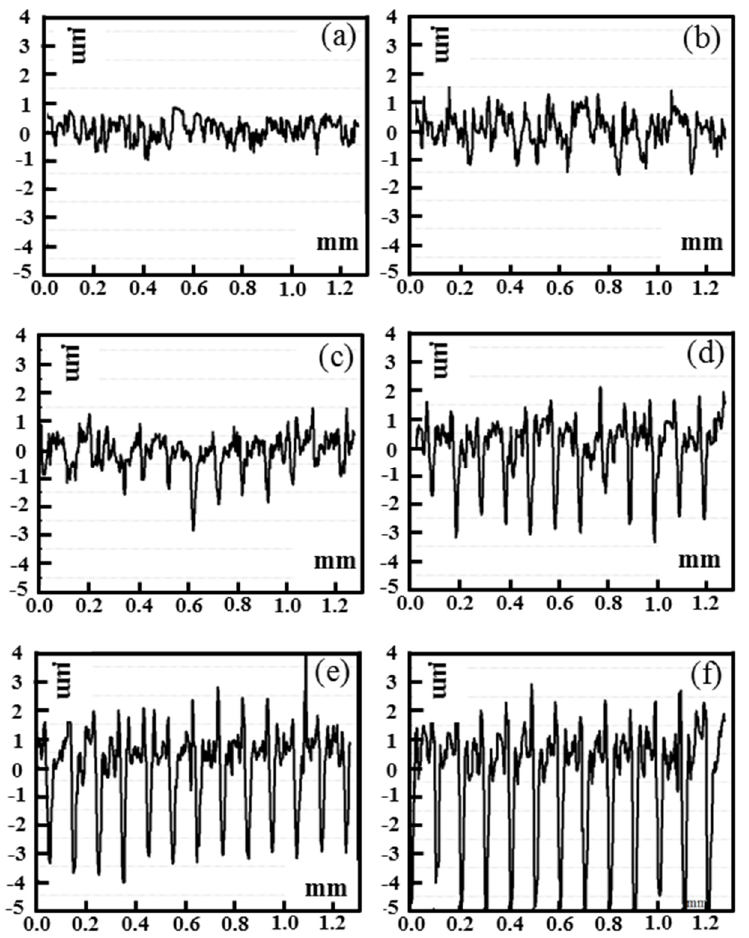
Figure 5. Surface roughness profile of the samples: ( a ) P-0, ( b ) P-1, ( c ) P-2, ( d ) P-3, ( e ) P-4, ( f ) P-5.